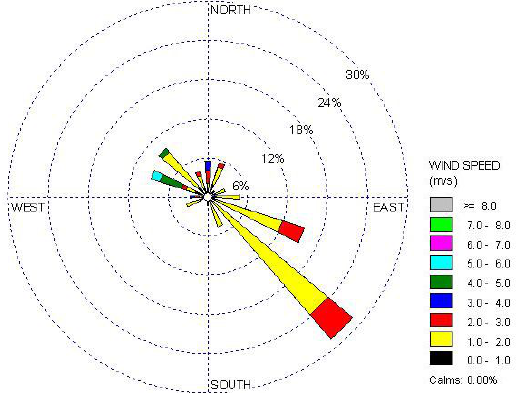
Fig. 3. Wind rose during the dust storm. Wind was observed by a three-axis sonic anemometer CSAT3 3m above the ground at SAOCL from 00:00 (Beijing Time), 27 March to 23:30, 29 March 2007. Southeast wind was dominant and the speed mainly ranged from 1.0 to 3.0 m/s.